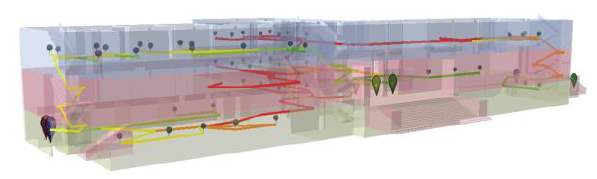
Figure 16. Generated library staff evacuation routes